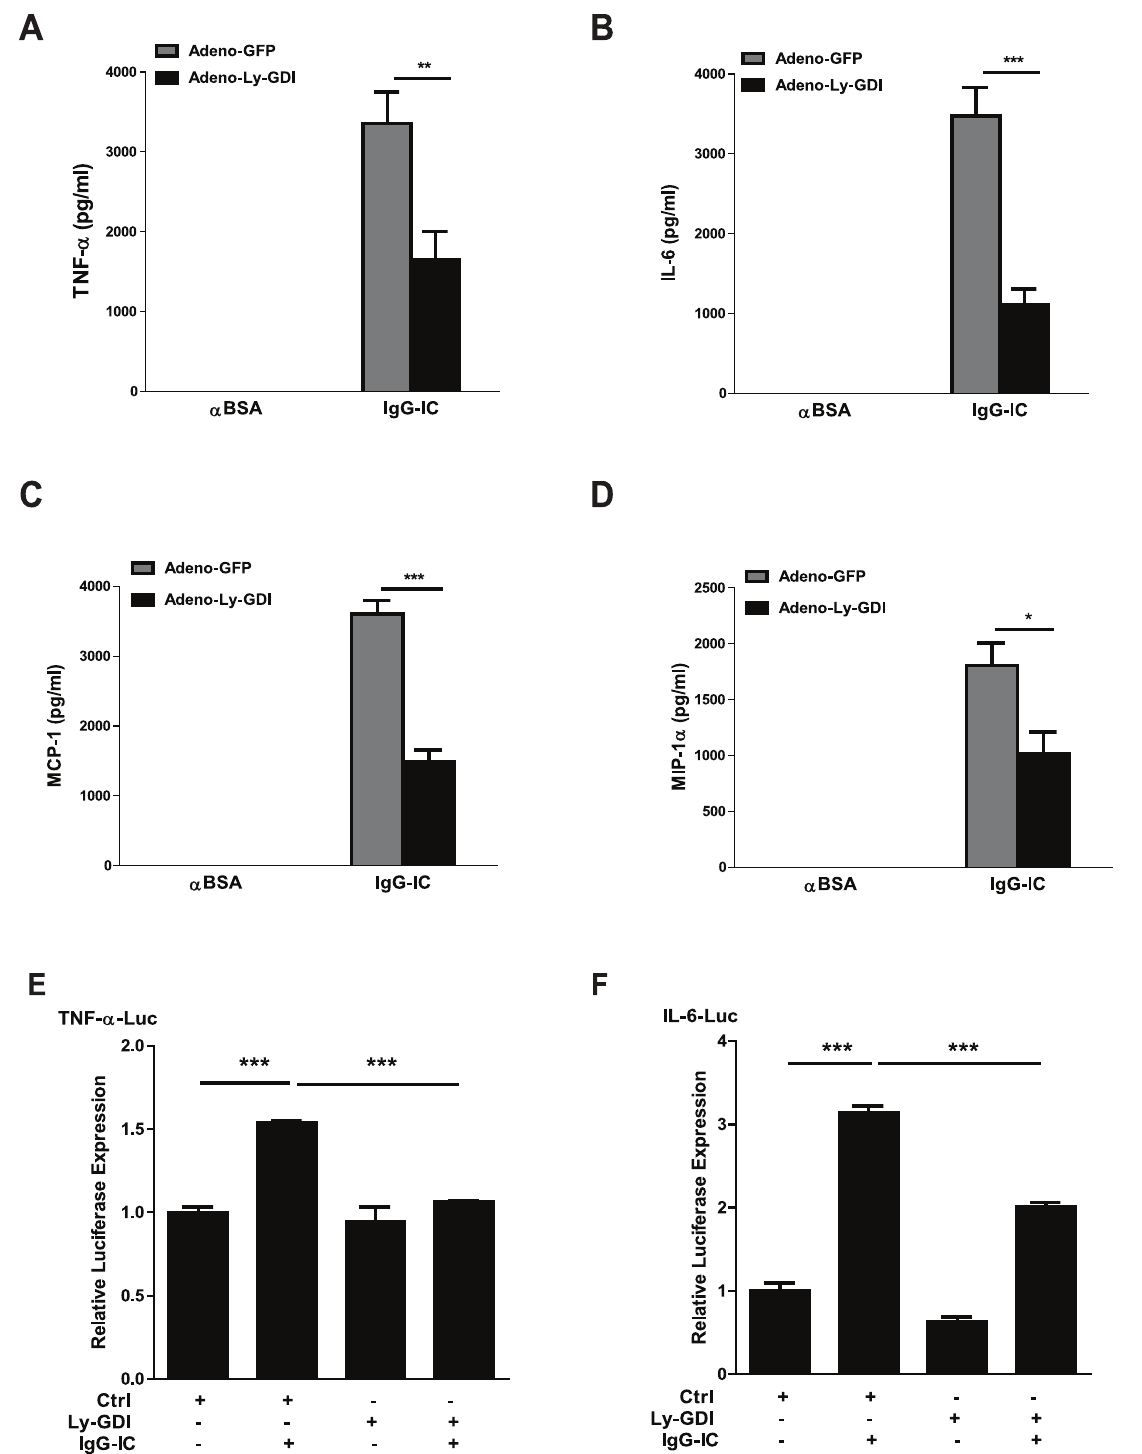
Fig 5. Over-expression of Ly-GDI decreases IgG immune complex-induced generation of pro-inflammatory mediators in BAL fluids. (A-D) Adeno- GFP or Adeno-Ly-GDI was injected to mice via an airway instillation at a dose of 5 × 10 8 PFU. 3 days later, the mice were subjected to IgG immune complex- induced lung injury or control treatment ( α BSA only). Cell-free BAL fluids were harvested 4 h later, and ELISAs were conducted to measure the TNF- α (A) , IL- 6 (B) , MCP-1 (C) , and MIP-1 α (D) levels. (E and F) MH-S cells were transiently transfected with indicated genes. 48 h later, the cells were treated with or without 100 μ g/ml IgG immune complexes for 4 h. The cell lysates were used to evaluate luciferase expression. Luminometer values were normalized for